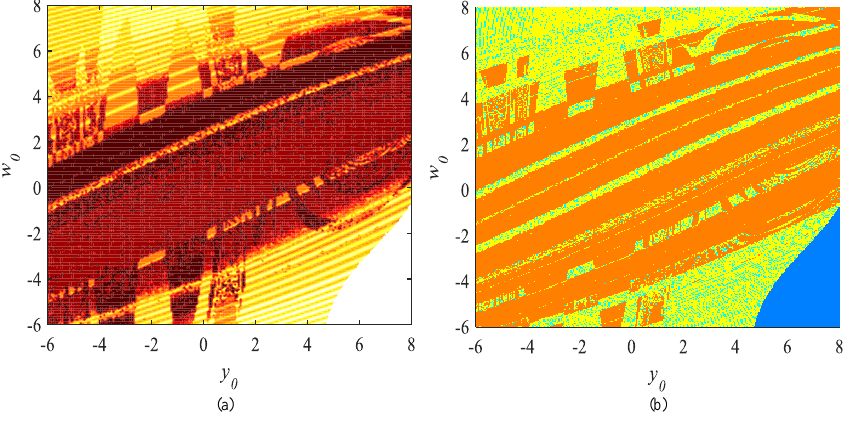
Figure 9. Dynamic maps in y 0 − w 0 : ( a ) based on SE complexity; ( b ) based on maximum Lyapunov